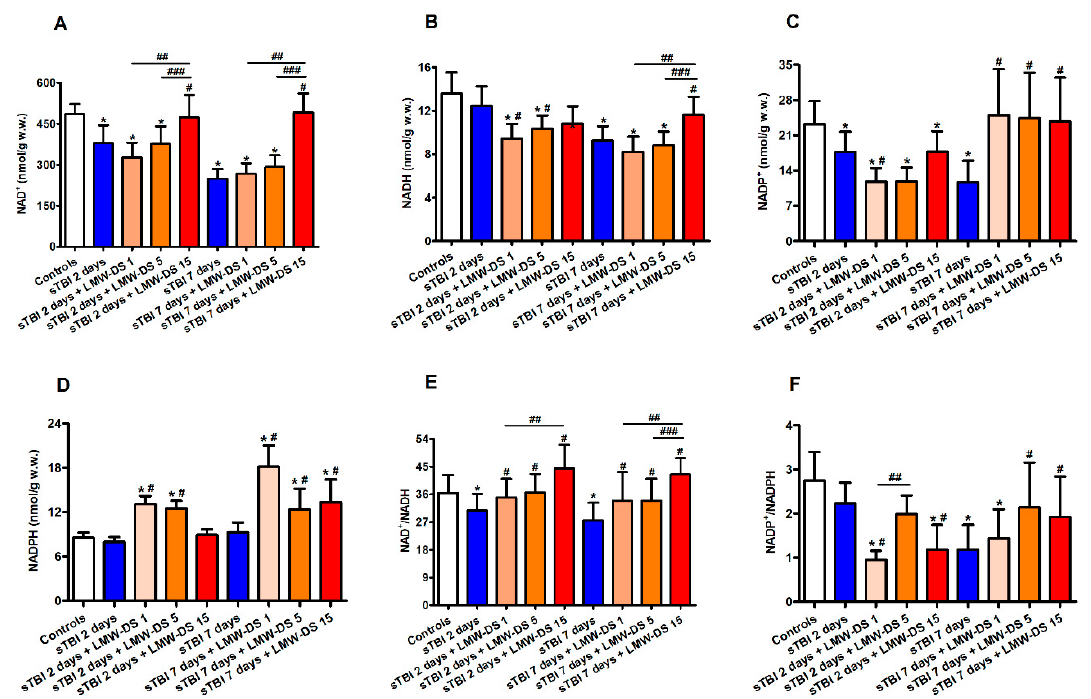
Figure 5. Effect of subcutaneous injection of increasing doses of LMW-DS (ILB ® ) on the cerebral concentrations of NAD + ( A ), NADH ( B ), NADP + ( C ), and NADPH ( D ), and of the NAD + /NADH ( E ) and NADP + /NADPH ( F ) ratios as valuable indicators of oxido-reductive metabolism of the nervous cell energy state. The parameters of interest were determined by HPLC on deproteinized cerebral homogenates at 2 and 7 days post-impact, both in untreated sTBI rats (TBI 2 days and TBI 7 days) and in rats receiving 1, 5, or 15 mg/kg b.w. LMW-DS (ILB ® ) administered 30 min after sTBI. Controls are represented by sham-operated rats. Values are the mean ± SD of 12 different animals and are expressed as nmol/g w.w. * Significantly different from sham-operated control rats, p < 0.05. # Significantly different from the corresponding time point of untreated sTBI rats, p < 0.05. ## Significantly different from LMW-DS 1, p < 0.05. ### Significantly different from LMW-DS 5, p < 0.05.